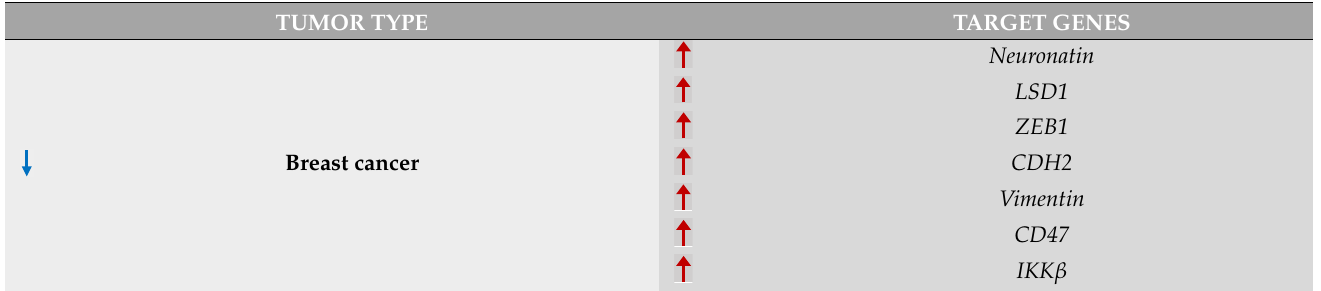
Table 1. MiR-708 target genes in different tumor types. Red arrows represent tumors in which miR- 708 or its targets are upregulated. Blue arrows represent tumors in which miR-708 or its targets are downregulated.